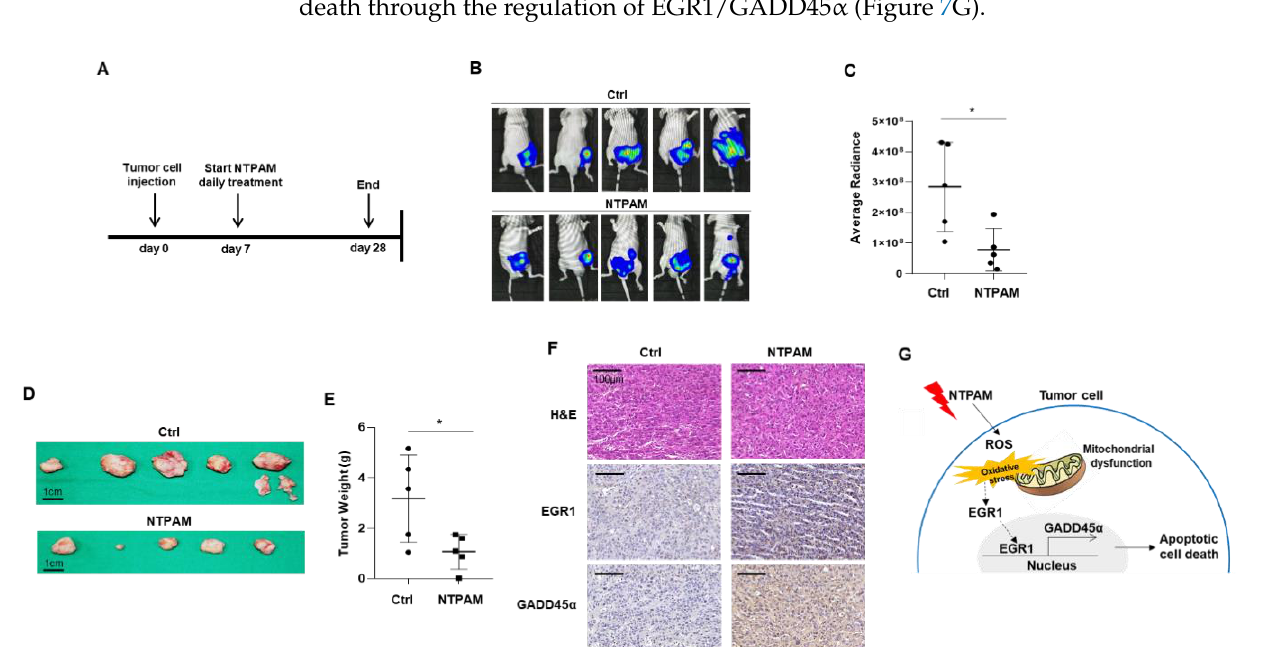
Figure 7. NTPAM exerts anticancer effects in a xenograft in vivo model. Luciferase-expressing FRO (FRO-Luc) THCA cells were injected subcutaneously into BALB/c-nude mice and treated with NTPAM every day for 3 weeks. ( A ) Schematic illustration of the in vivo experimental design. ( B ) Final tumor images of cancer cells tracked with the IVIS imaging system following the injection of mice with FRO-Luc cells. ( C ) The luminescence radiance of the ROI of the tumor was determined. Results were analyzed using Mann-Whitney U test. ( D ) Final tumor images. ( E ) Final tumor weight. Tumor tissues were extracted after the final determination of tumor growth. Results were analyzed using Mann-Whitney U test. ( F ) Representative images of H&E and immunohistochemical staining of control and NTPAM group. ( G ) The proposed NTPAM-induced ROS/EGR1/GADD45α axis in THCA based on this study. Data were expressed as mean ± standard deviation of the mean (±SD). Differences were considered relevant at p < 0.05 (* p < 0.05).